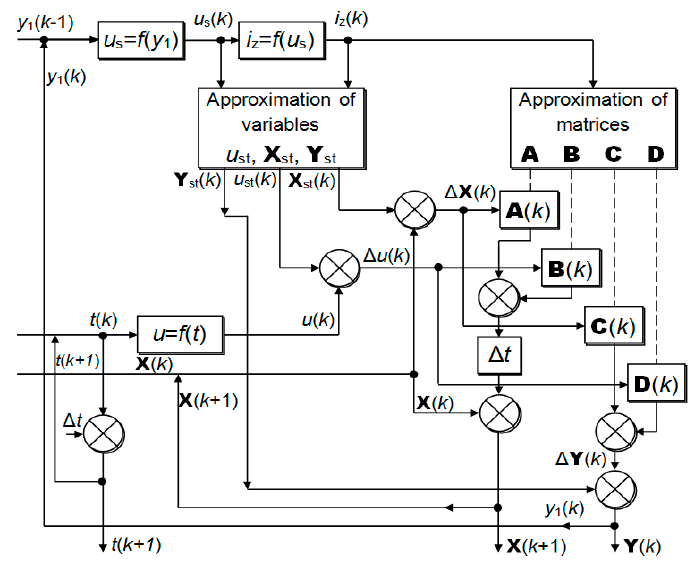
Figure 2. Block diagram of the hybrid dynamic model operation.